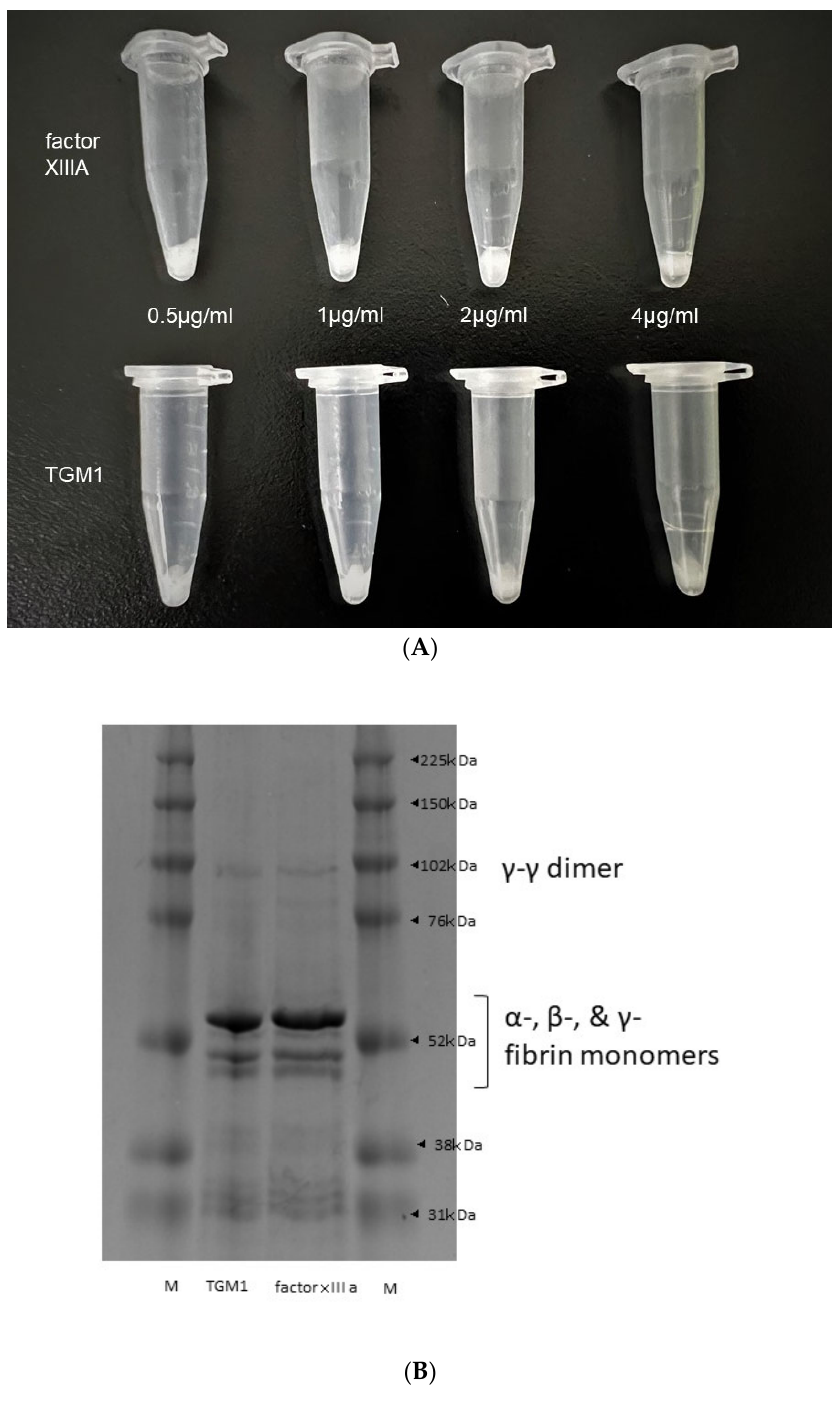
Figure 5. The clotting effect of TGM 1 compared to factor XIIIA. Fibrin clot after the removal of supernatants. ( A ) 0.5, 1, 2, 4 μ g/mL factor XIIIA (upper from left to right) and 0.5, 1, 2, 4 μ g/mL TGM 1 (lower from left to right) showed a similar formation of fibrin clot by visual inspection. ( B ); SDS ‐ PAGE showed the similarity of the migration pattern of fibrin monomers and polymers obtained using TGM 1 and factor XIIIA.